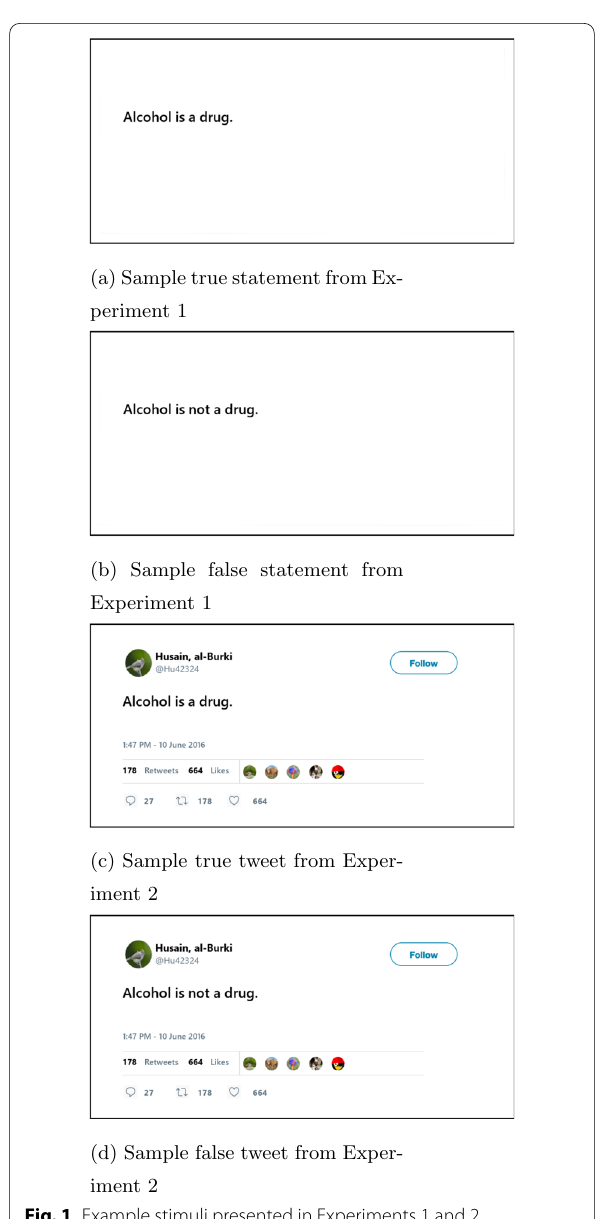
Fig. 1 Example stimuli presented in Experiments 1 and